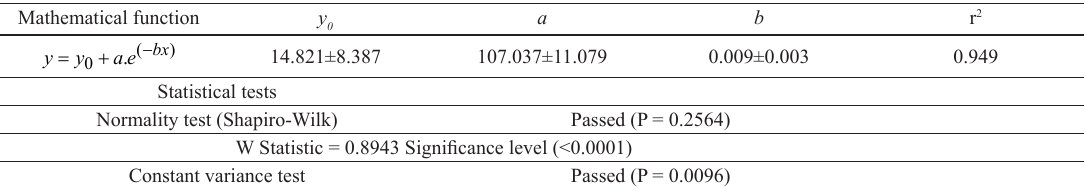
Table 5. Statistic parameters of the exponential model for elongation versus dose